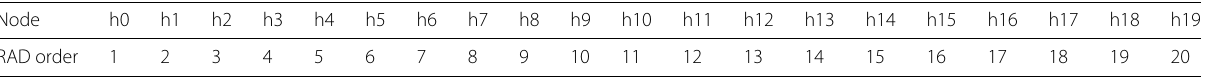
Table 6 Order of expiring chalone wait and inhibitor wait (e.g., h0 has the smallest wait and h20 has the largest wait) Node h0